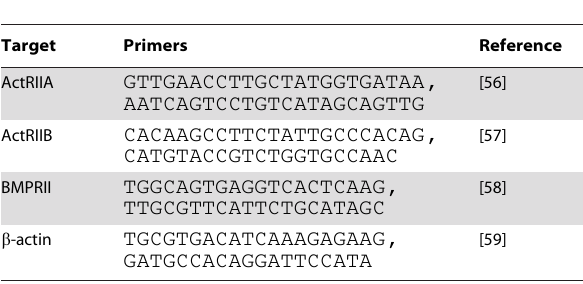
Table 1. Primers for real-time quantitative